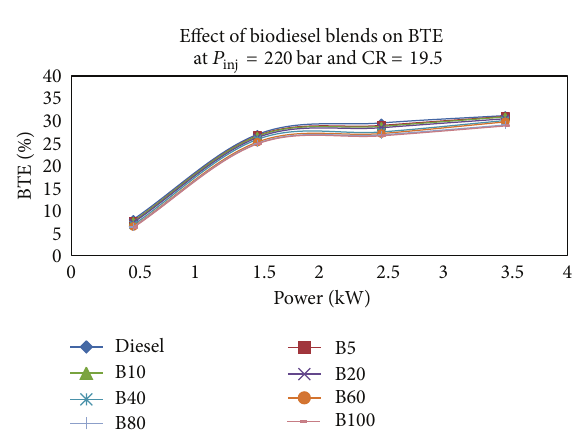
Figure 28: Variation in BTE for various biodiesel blends at 𝑃 180 bar and CR